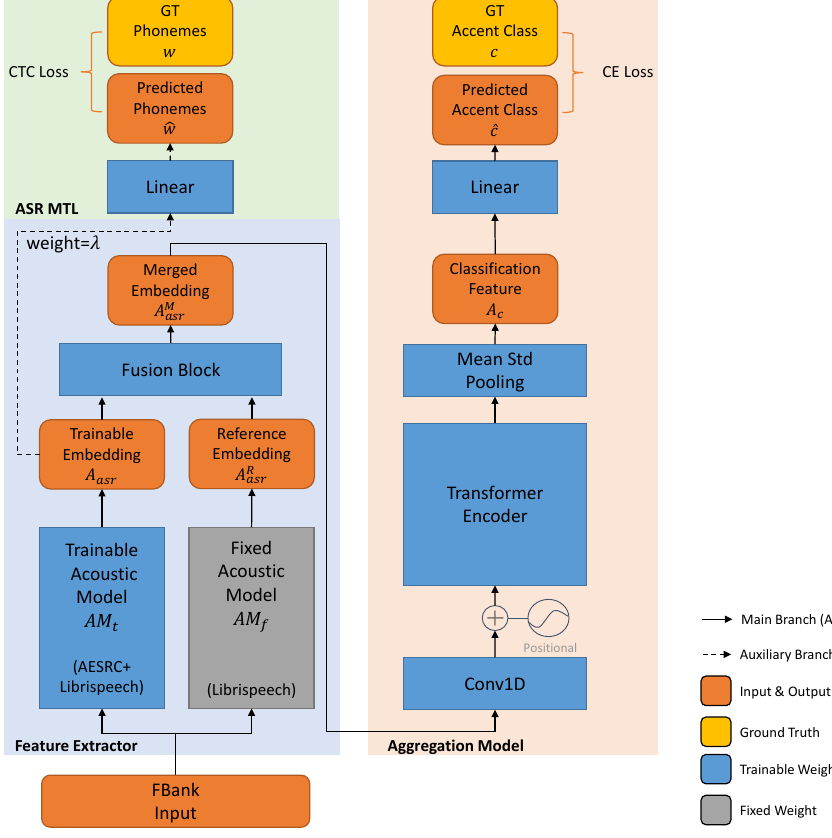
Figure 1. Proposed hybrid structure for accent recognition. We list the dataset used for the acoustic model ( AM ) in the brackets and use the gray color to indicate the fixed acoustic model does not participant in the AR training process. The auxiliary branch plotted in dash line (the green block) is used only during